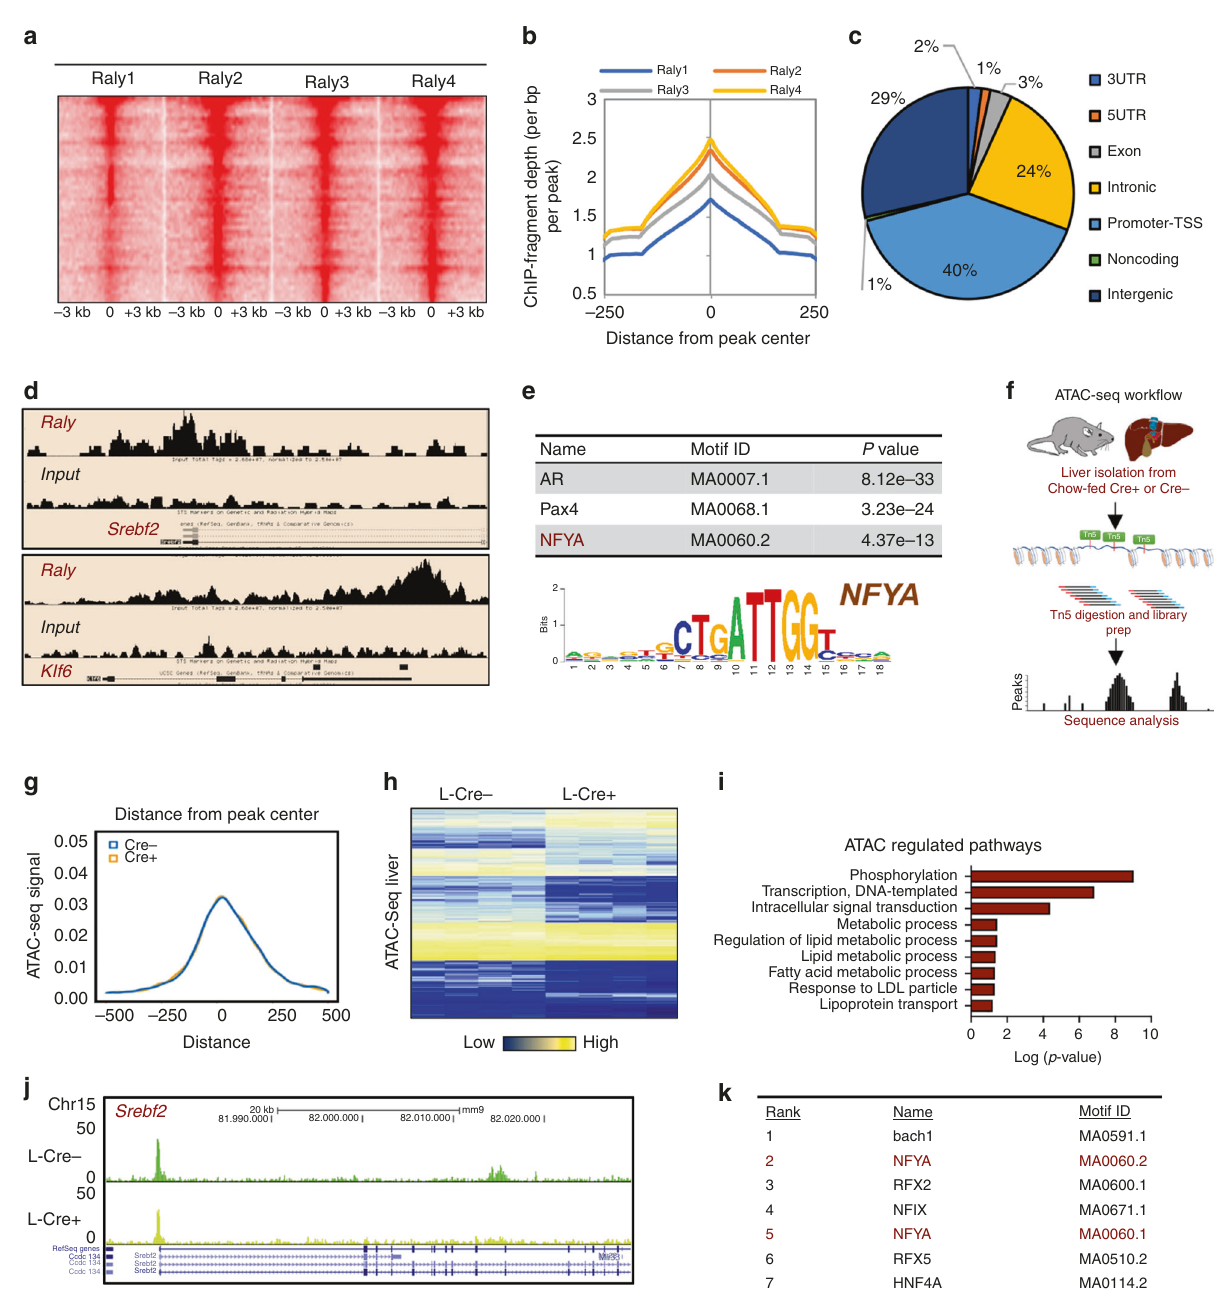
Fig. 3 Interrogation of the RALY cistrome and chromatin dynamics enriches for promoter binding and metabolic coregulators. a Heat map of reproducible counts centered around a gene transcription start site for RALY ChIP-seq samples in hepa1-6 cells ( n = 4 per group). b ChIP fragment depth enrichment for RALY across samples. c Pi chart showing the binding pattern of RALY according to the location of a given peak. d Representative RALY ChIP-seq pro fi les at Srebf2 and Klf6 loci. e Motif analysis surrounding called peaks from RALY ChIP-seq in hepa1-6 cells. f Schematic of ATAC-seq work fl ow. g Metagene representation of the mean ATAC-seq signal. ATAC-seq was performed from mice liver with Raly f/f L-Cre + or Cre − ( n = 4 per group). h , i Heat map shows the differential enrichment of ATAC peaks of Cre − or Cre + livers and Gene ontology analysis. j Representative ATAC-seq heat map in liver with Raly f/f L-Cre + or Cre − at the Srebf2 locus. k Motif analysis showing top enriched factors at differentially regulated sites from Raly f/f L-Cre + or L-Cre −